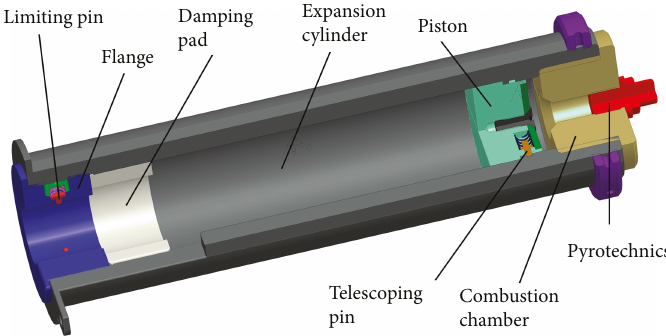
Figure 5: Schematic diagram of the advancing